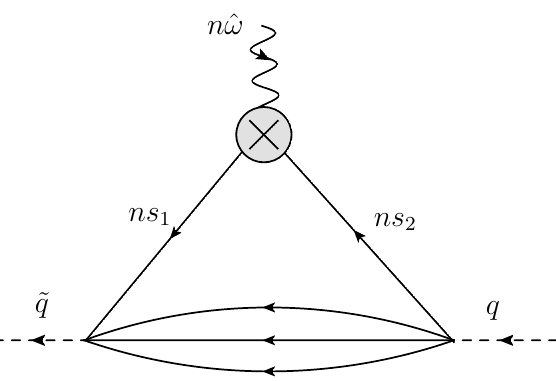
Figure 5 . Diagrammatic interpretation of the one-point correlation (C.9). The grey blob represents the detector and the arrows indicate the propagation direction of the